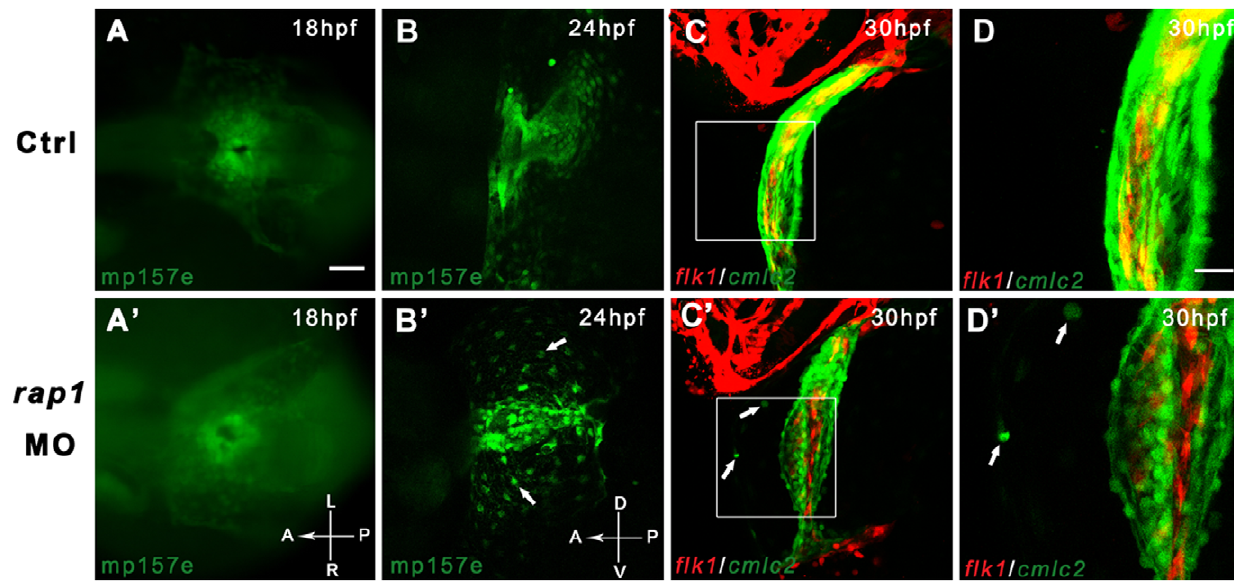
Figure 2. Time-lapsed observation revealed abnormal heart development in Rap1 knock-down zebrafish. Transgenic fish mp157e without any injection (A) and injected rap1 MO (A’) were indistinguishable in early heart development. By 24 hpf, rap1 MO injected mp157e embryos, crossed in flk1:mCherry background, started to show abnormality in heart development and remodeling (B to B’), including the failure of heart tube extension, abnormal cardiac looping and incomplete heart chamber formation. In higher magnification views, the morphants show that a small portion of GFP labeled cardiac cells (arrows in B’ to D’) did not migrate properly to be eventually packed in the heart tube. Dorsal view, head to left in A to C and A’ to C’. Lateral view, head to left in B to D and B’ to D’. Scale bar, 100 m m in A to C, and A’ to C’; 40 m m in D and D’.